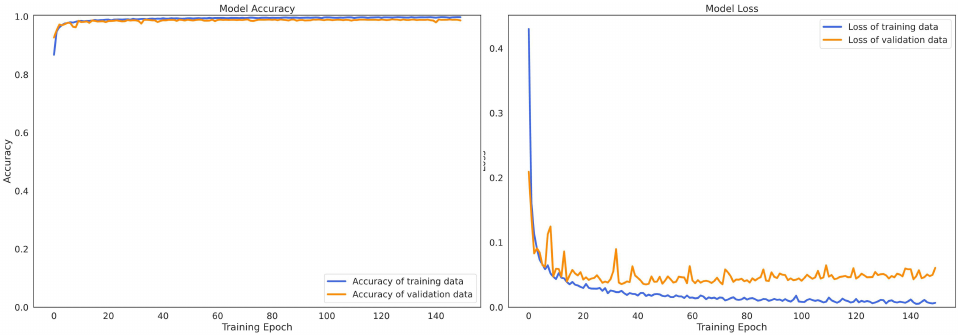
Figure 9. The change of model accuracy and loss in the training and validation data of the SEResNet- BiGRU on HAPT dataset.